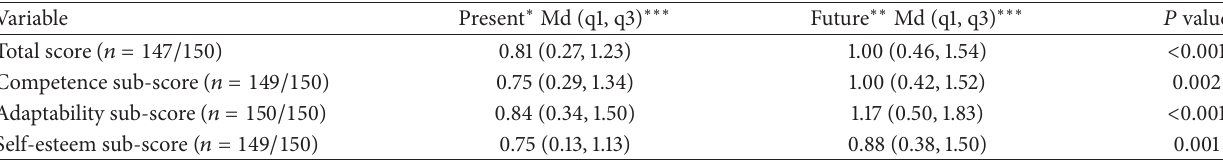
Table 2: PIADS total score and subscores for web-based e-health services in present and mobile health applications in the future.